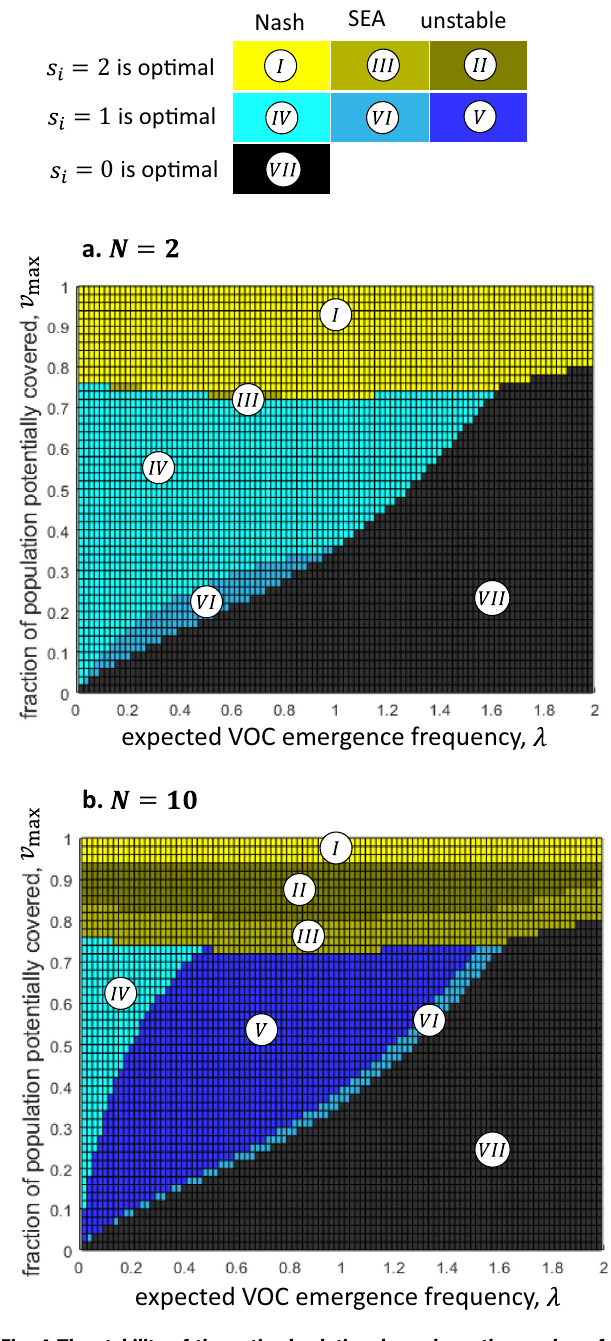
Fig. 4 The stability of the optimal solution depends on the number of vaccine-rich countries. The optimal solution does not depend on the number of vaccine-rich countries, N , as long as v max is held constant; however, the optimal solution is stable for a wider range of parameters if N is smaller. Each coloredrectangleonthetoppanelrepresentsthesolutionforthecorresponding values of λ and v .In regions I , II , and III (yellow shades), s i ¼ 2 by all vaccine- max rich countries is optimal. In regions IV , V , and VI (blue shades), s i ¼ 1 by all countries is optimal. In region VII (black), s i ¼ 0 by all countries is optimal. The only difference in parameters between the panels is that N ¼ 2 in panel ( a ) and N ¼ 10 in panel ( b ). α ¼ 0 : 4 in both panels. The case of N ¼ 6 is demonstrated in Fig. 2. Note that in panel ( a ), where N ¼ 2, the optimal solution is stable (Nash equilibrium or self-enforcing international agreement (SEA)) for all values of v max and λ ; but in panel ( b ), where N ¼ 10, there are parameter regions in which the optimal solution is unstable (regions II and V